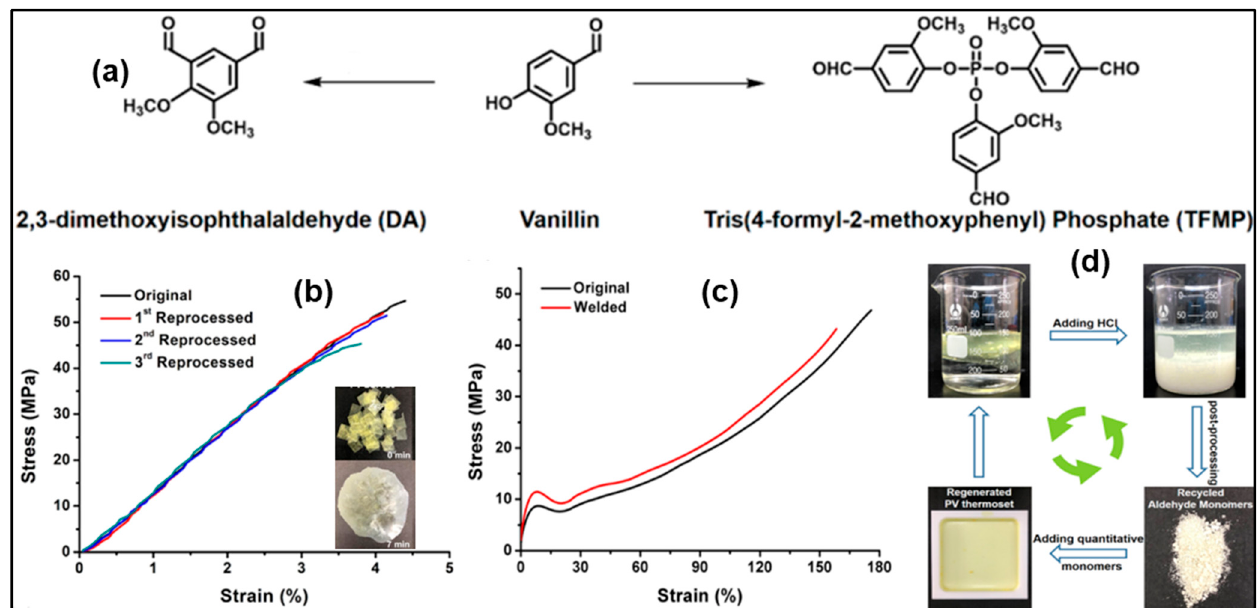
Figure 20. ( a ) Synthesized pathway of aldehyde from vanillin; mechanical recycling ( b ) and weldability ( c ) performance; and ( d ) closed-cycle chemical recycling [reproduced with permission from Hong et al.; published by ACS, 2022] [83].